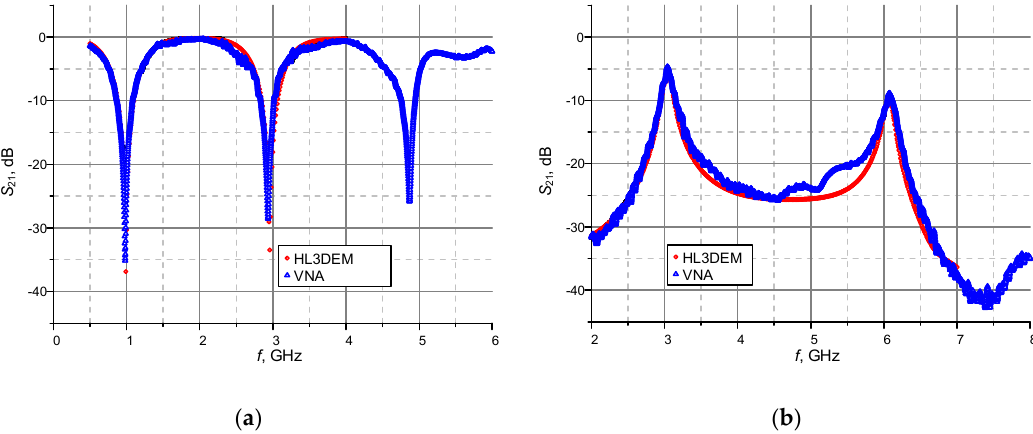
Figure 12. Confirmation of measurement procedures: ( a ) For T-resonator, LTCC FERRO A6-5 substrate, f 0 = 1 GHz; ( b ) For modified ring resonator, ISOLA FR408 substrate, f 0 = 3 GHz.